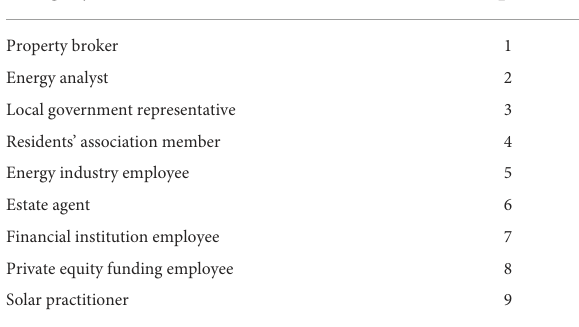
TABLE 1 Participants’ category and